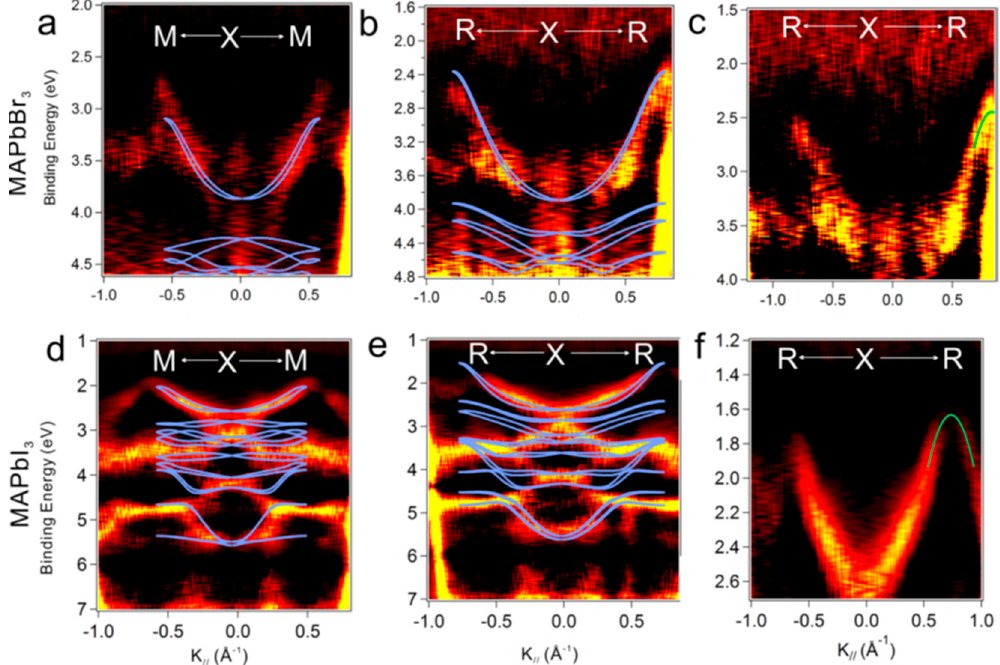
Figure 15. ARPES k-space 2D curvature band maps. Top row: MAPbBr 3 single crystal along the ( a ) XM and ( b ) XR high-symmetry directions. Bottom row: MAPbI 3 single crystal along the ( d ) XM and ( e ) XR high-symmetry directions. In all plots, corresponding DFT-calculated bands are shown with light blue lines (shifted in energy to match experimental band positions). A zoom into the topmost VB along the XR direction is given in ( c ) for MAPbBr 3 and in ( f ) for MAPbI 3 . Fitting the VB edge regions with parabolic curves (green lines) yields a hole effective mass near R of ∼ 0.25 ± 0.05 m 0 for MAPbBr 3 and ∼ 0.50 ± 0.10 m0 for MAPbI 3 . From Ref. [114] with permission.